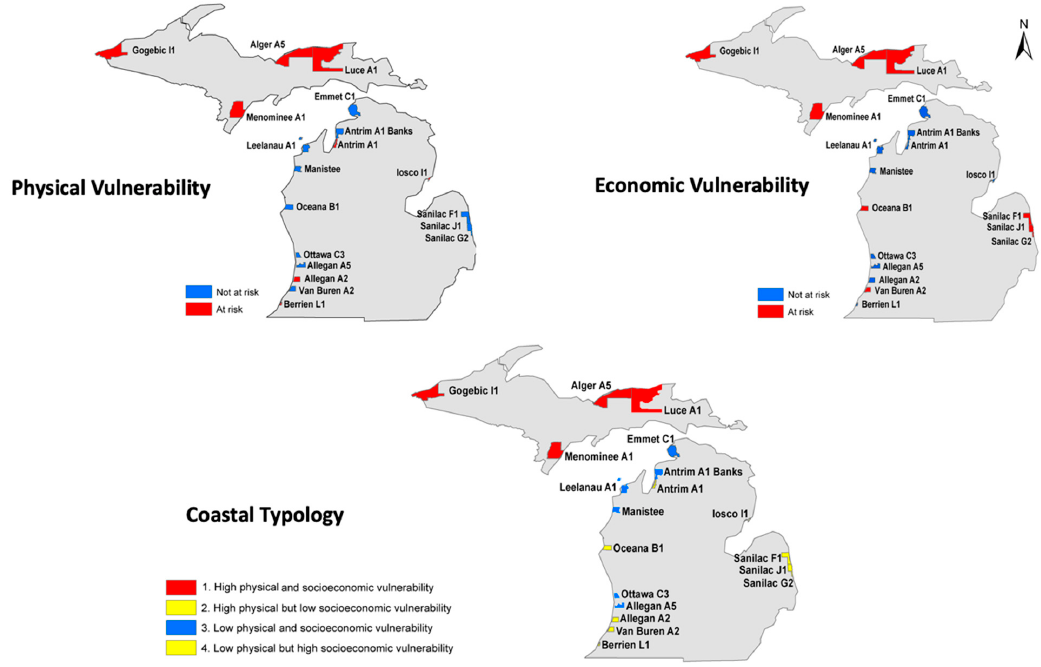
Figure 5. Physical and Socioeconomic Vulnerability from 2010–2014. Note: The colors are designed to match the typology in Figure 3.